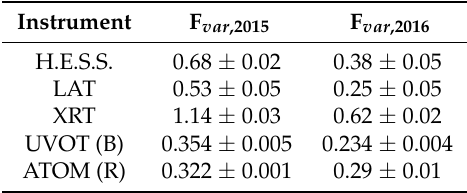
Table 1. Fractional variability amplitudes for H.E.S.S., Fermi -LAT, Swift-XRT, Swift-UVOT and ATOM observations of PKS2155-304 collected in 2015 and